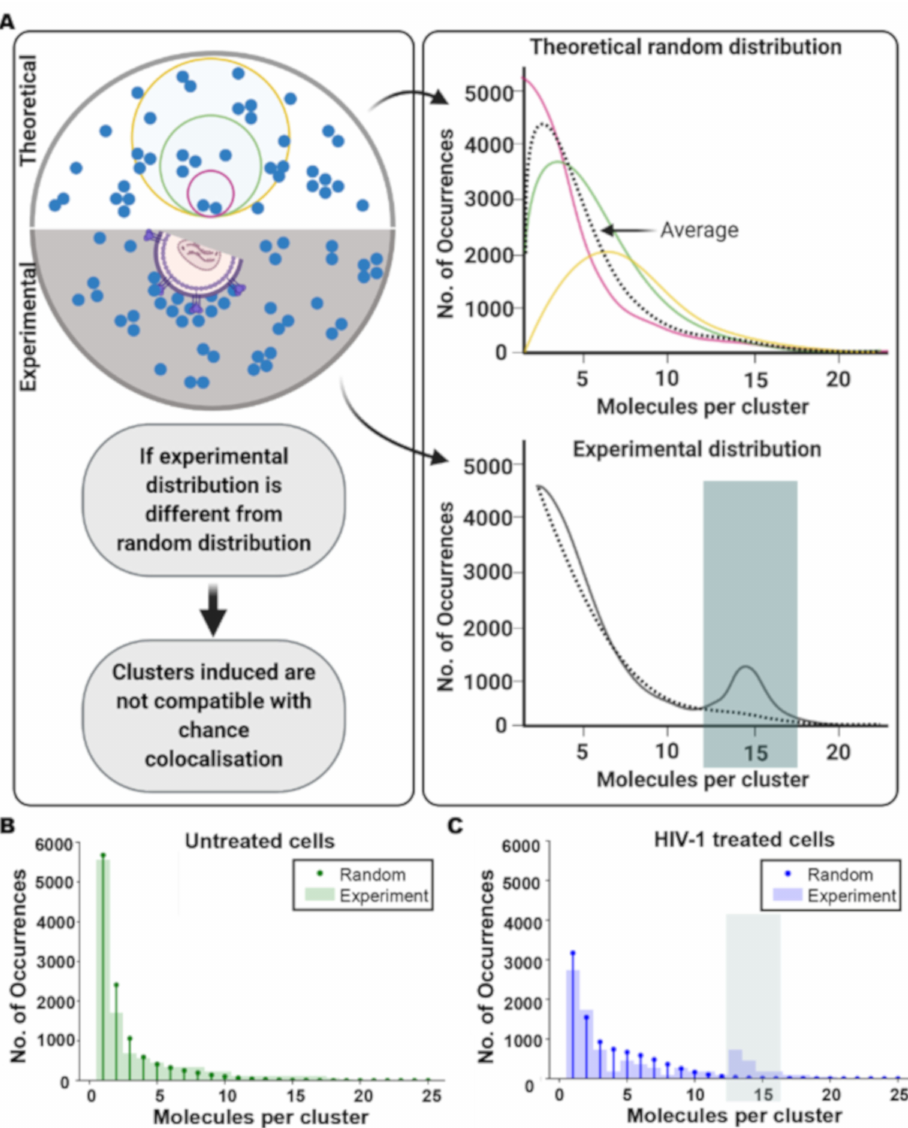
Figure 4. Statistical modelling of CD4 surface distribution. ( A ) Model schematic (Top): counting CD4 molecules (blue) in membrane areas of different sizes (small (pink), medium (green) or large (yellow)) compared to a theoretical model based on an averaged Poisson distribution that corresponds to a random distribution of receptors on the cell surface and to multiple measurements in membrane areas (clusters) of different sizes (the black line is the average of Poisson distributions for different cluster sizes [pink, green, yellow]). Bottom: Experimentally determined distribution: HIV binding alters the organisation of receptors, the occurrence of clusters of a certain number of molecules per cluster is altered (solid line) and the distribution differs from the expected averaged Poisson distribution (dotted line). ( B , C ) Comparison of modelled (‘Random’) and measured distributions of the numbers of molecules per cluster for untreated cells ( B ) and HIV-treated (bound) cells ( C ). The discrepancy between the predicted model and the experimental data in HIV-treated cells is highlighted in green shading in A and C . Data from at least three separate experiments and total 15 different cells in each condition,